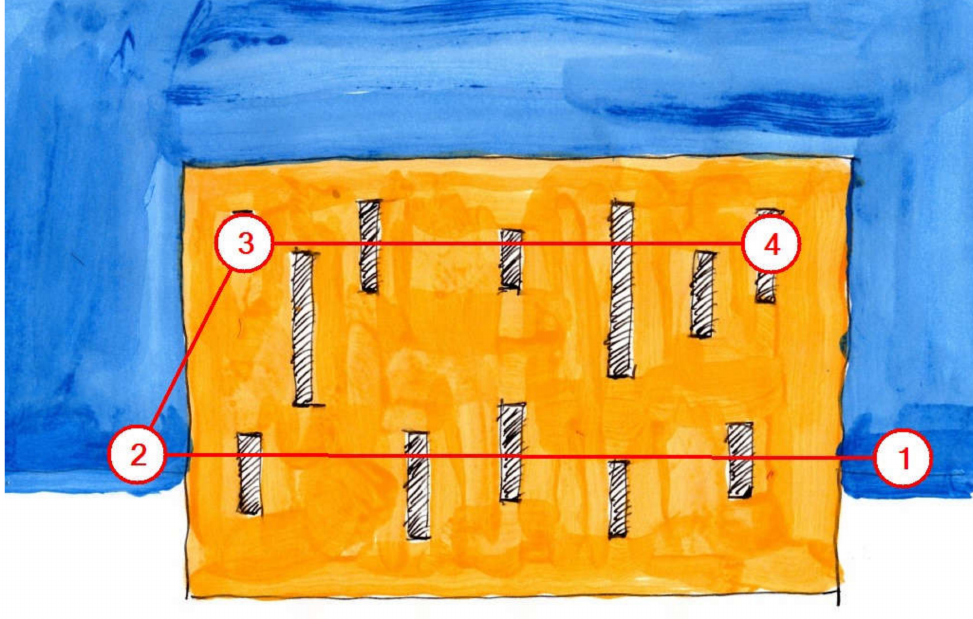
Figure 7. Scanning sequence for contemporary building with unaligned vertical slit